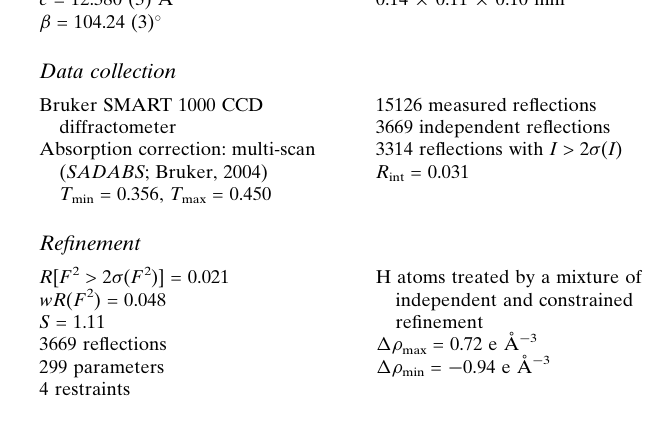
Bruker SMART 1000 CCD diffractometer Absorption correction: multi-scan ( SADABS ; Bruker, 2004)